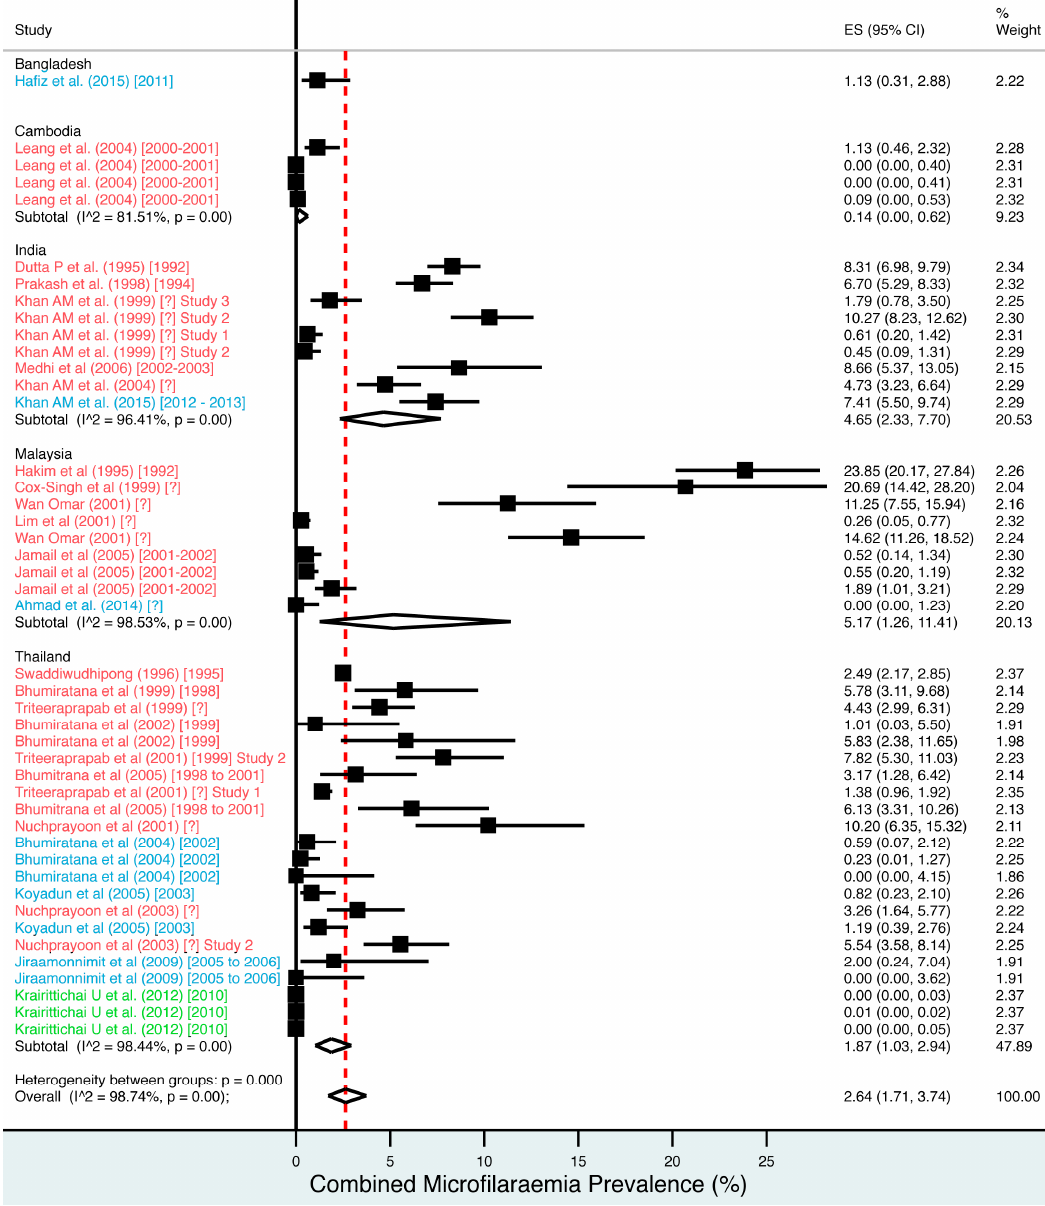
Figure 3. Percentage estimates of combined microfilaraemia prevalence by country and year. ES: prevalence estimate. Red-dashed line: overall estimate. Diamond: subgroup estimate. Horizontal line: 95% CI. Red study: pre-MDA, blue study: mid-MDA, green study: post-MDA. For microfilaraemia, 30 studies testing 133,747 individuals estimated a pooled prevalence of